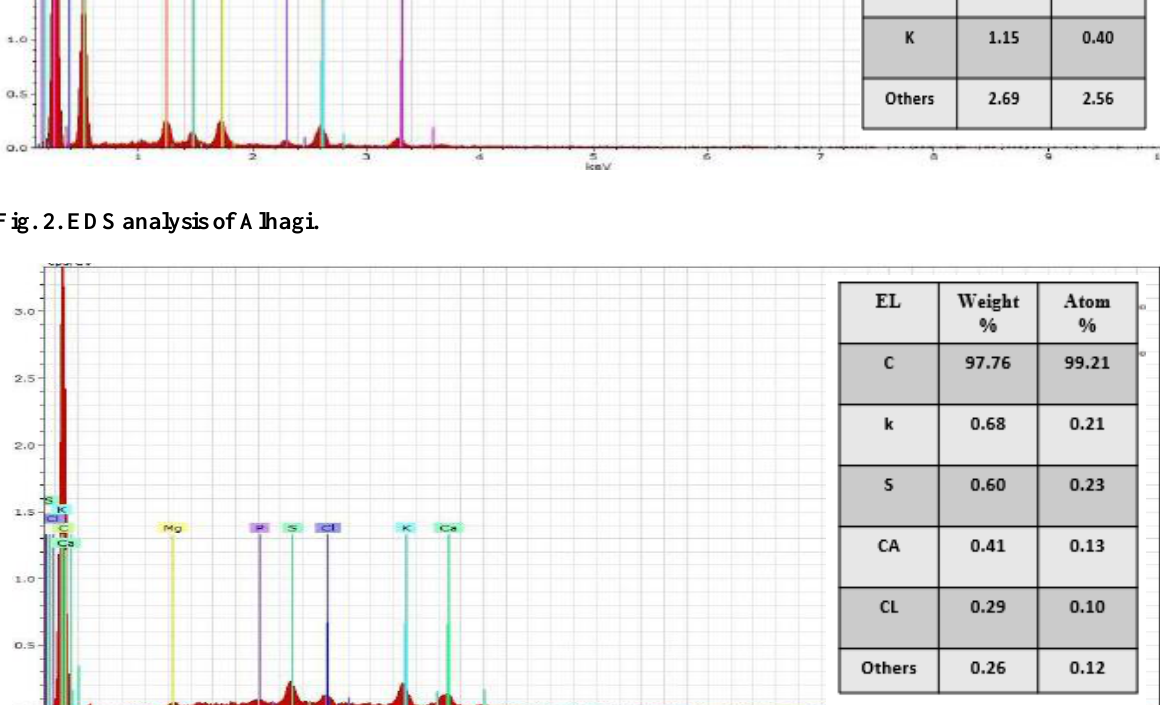
Fig. 3. EDS analysis of